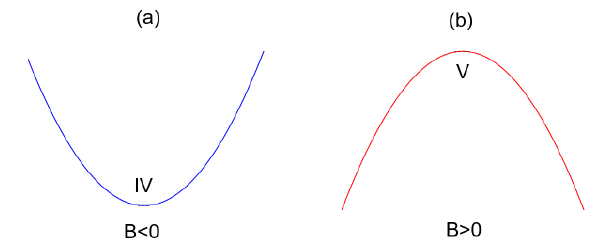
Figure 4. The potential U graph for oscillator (14) in case K ( 0 ) = 0. ( a ) B < 0. ( b ) B >